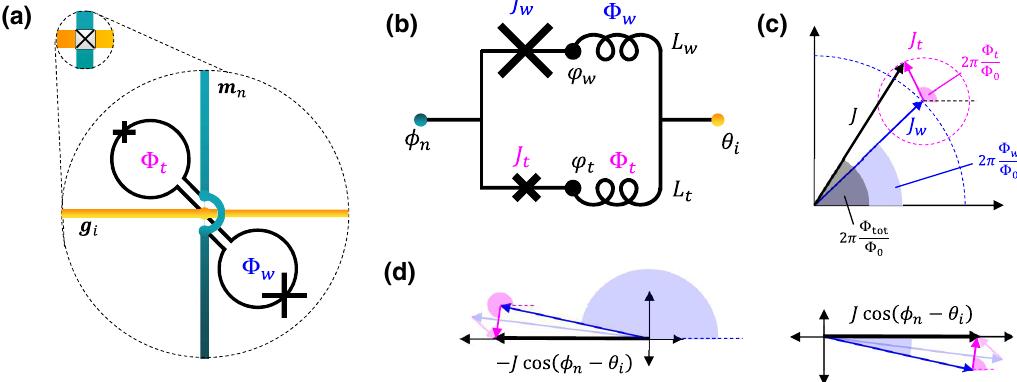
FIG. 7. Realistic circuit for a single site of the lattice in Fig. 1. Panel (a) shows how each Josephson junction in Fig. 1(a) is replaced by an asymmetric dc SQUID (b), whose two arms are individually flux-biased with fluxes (cid:6) w and (cid:6) t . Panel (c) illustrates how the effective total Josephson potential for the SQUID can be viewed schematically with a phasor diagram, in which the two Josephson energies J w and J t can be viewed as adding vectorially. Panel (d) then shows how tuning the two fluxes can be used to realize the correct ± 1 elements of the W matrix in Eq. (4b). Shaded arrows in these panels indicate how adjustments to these fluxes can also be used to null out spurious, small variations in the Josephson energies due to fabrication